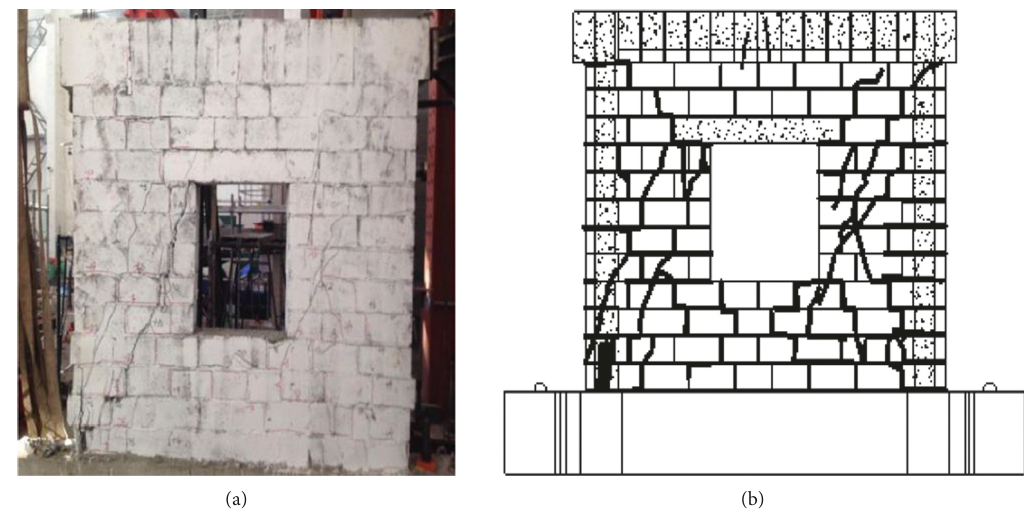
Figure 10: (a) Failure mode and (b) crack distribution of wall A3.